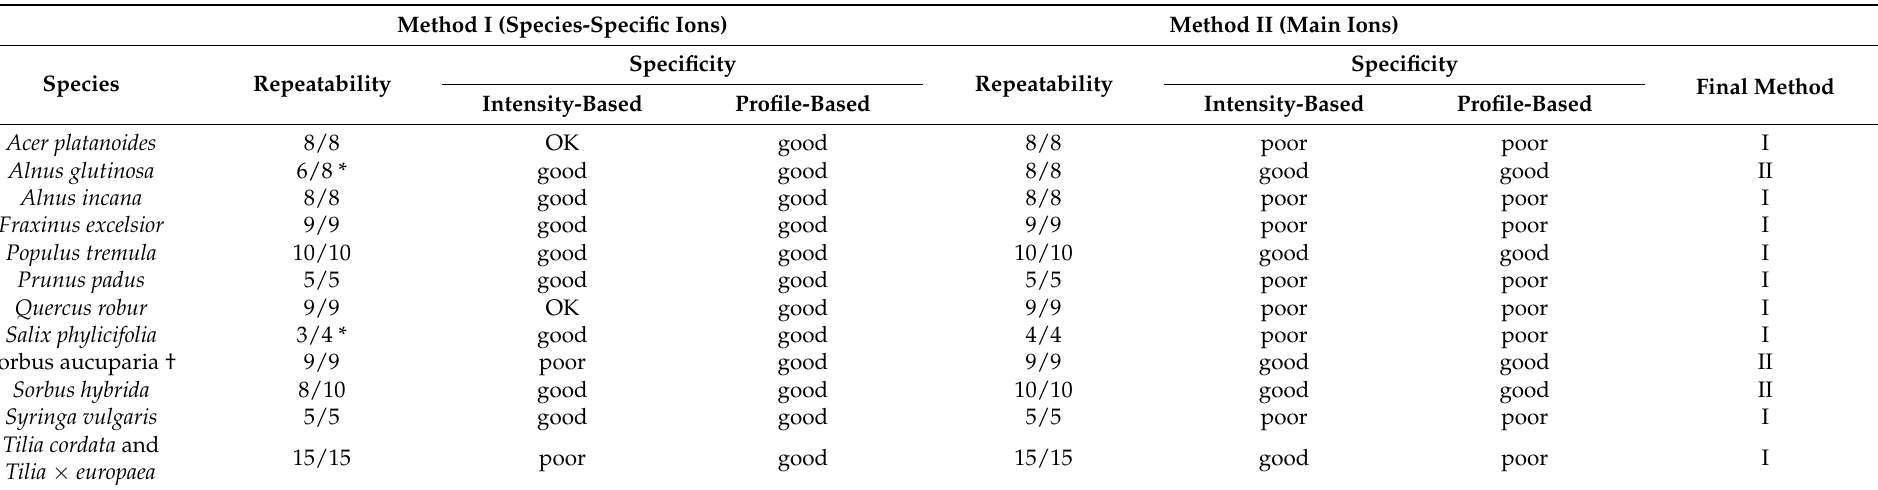
Table 1. Comparison of two fingerprinting methods. Repeatability is denoted as the number of replicates that produced similar fingerprints for all replicates. Intensity-based specificity was ranked as good if the species in question produced the most intensive signal, OK if one other species produced as intensive a peak as the species in question, and poor if the fingerprint of some other species was the most intensive. Profile-based specificity was ranked as good if the fingerprint profile of the species in question was unique and poor if the fingerprint profile of the species in question showed the same peaks as other species.